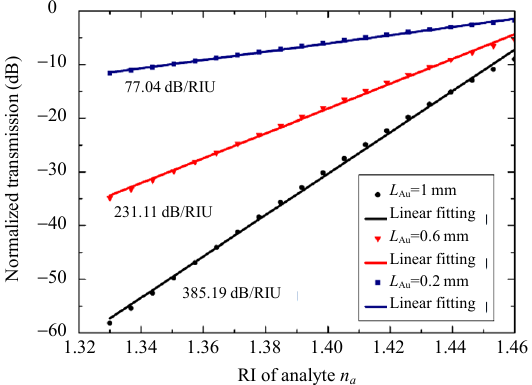
Fig. 9 Dependence of normalized transmission on RI of analytes for different sensing lengths of 1 mm, 0.6 mm, and 0.2 mm.